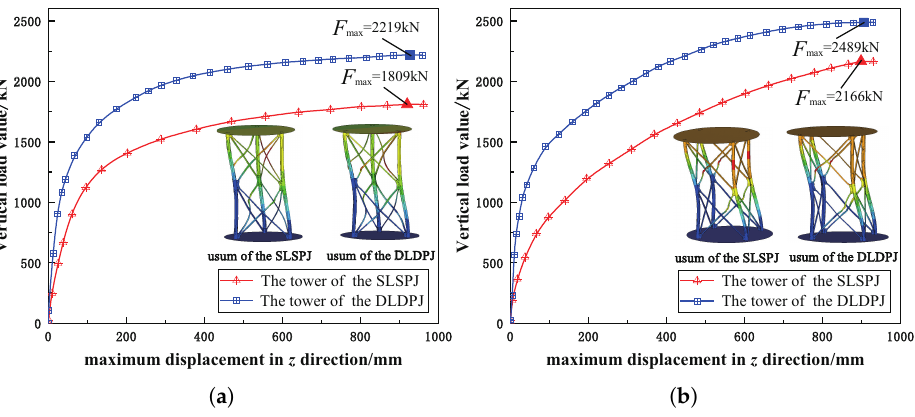
Figure 15. ( a ) The load–displacement curve of the triangular tower. ( b ) The load–displacement curve of the quadrilateral